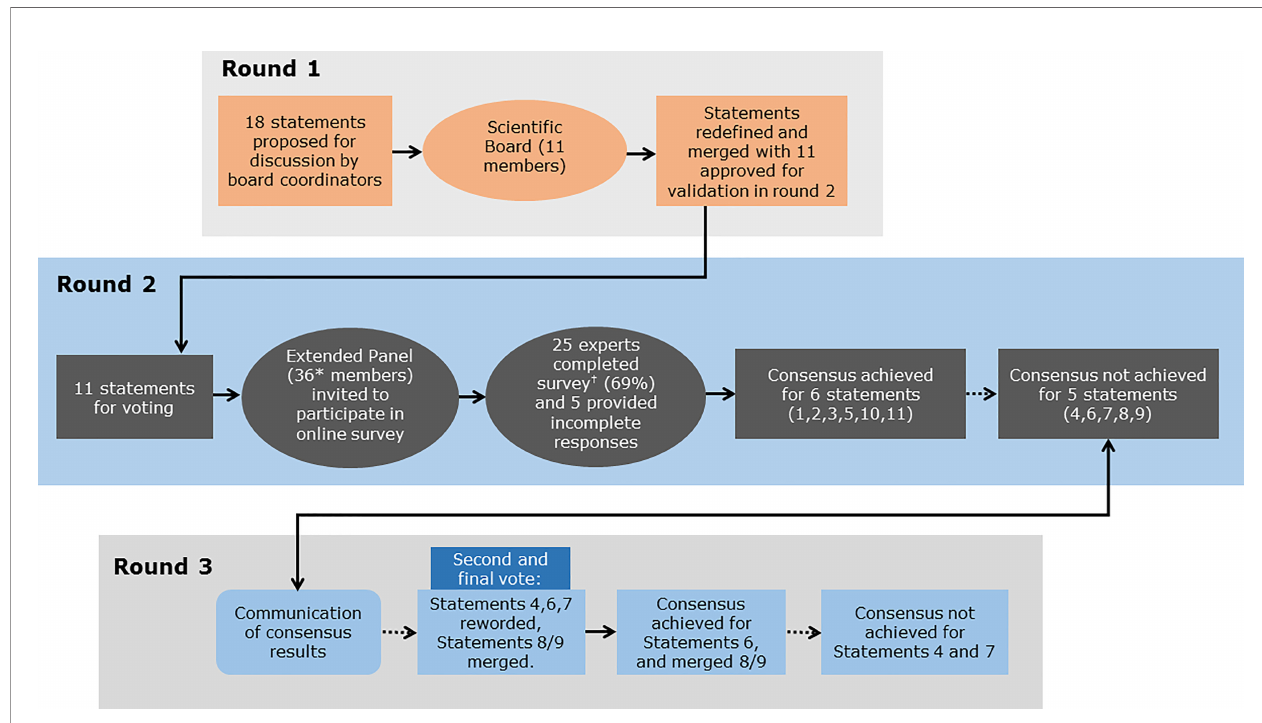
FIGURE 1 | Overview of the Delphi consensus process and outcomes. Round 1: Statements and supporting references initially developed by the two Scienti fi c Coordinators were discussed and amended by the 11 members of the Scienti fi c Board. Round 2: An Extended Panel of 36 experts were invited to vote on their level of agreement or disagreement with each statement in an online survey, of which 25 experts completed the survey and fi ve provided incomplete survey responses. Round 3: The consensus results were communicated to the participating experts. Statements that did not achieve consensus in Round 2 were discussed and revised or merged. The Extended Panel then voted on their level of agreement or disagreement with the revised statements. *9 members of the Scienti fi c Board and 27 additional experts suggested by the Scienti fi c Board; † 9 members of the Scienti fi c Board and 16 additional experts suggested by the Scienti fi c